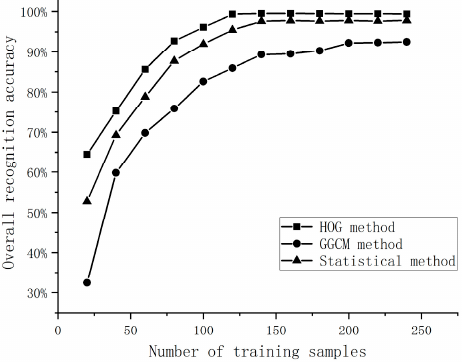
Figure 8. Tendency of the overall recognition accuracy related to the number of training samples.